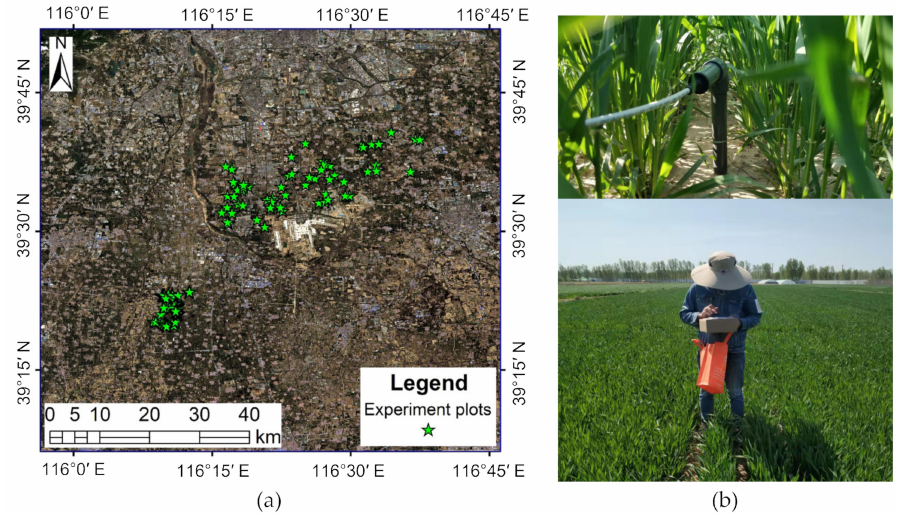
Figure 2. Basic information of in situ measurements: ( a ) distribution of experimental plots in the study area; ( b ) photograph of the scene.